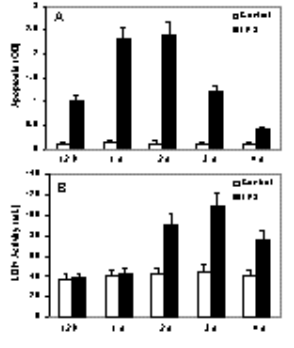
Fig. 2. Time-courses of apoptosis and necrosis. Mice were treated with LPS (30 µ g) and BAL was analyzed at indicated times. Data are shown as the mean + SEM, n = 4